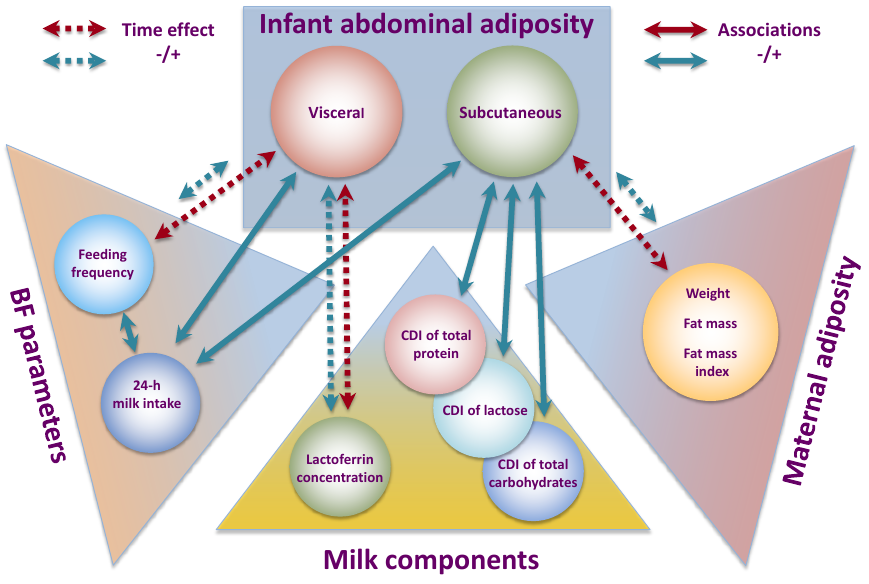
Figure 3. Suggested pathways of lactocrine programming of the infant abdominal adiposity during first 12 months postpartum. Associations between tested parameters and infant abdominal adiposity are indicated by the arrows (green—positive associations; red—negative associations); dotted arrows indicate time-dependent associations. BF—breastfeeding; CDI—calculated daily